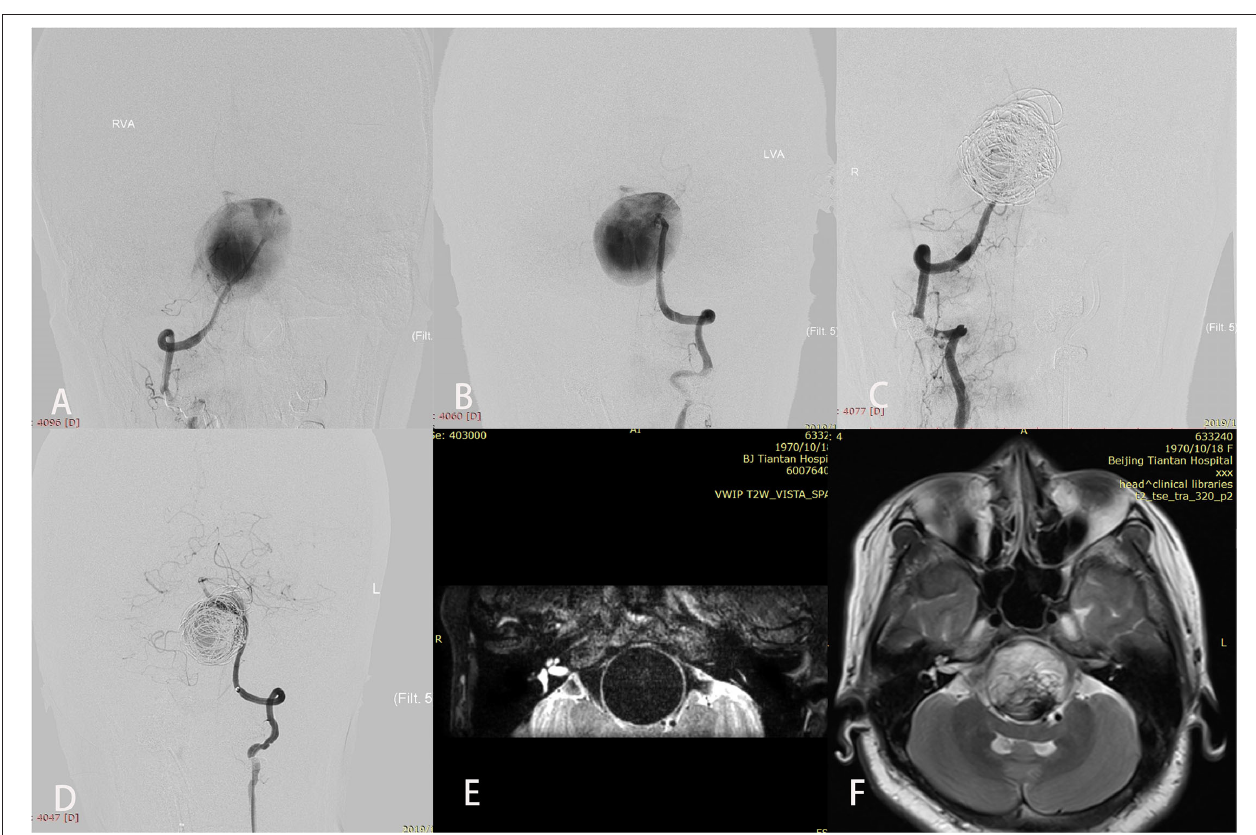
FIGURE 2 | A patient (case 17) with symptoms of mass effect from a giant vertebrobasilar junction aneurysm underwent placement of a single Pipeline embolization device along with coiling and right vertebral artery sacrifice. After treatment, disturbed consciousness and dyspnea developed. Preoperative anteroposterior views of right (A) and left (B) vertebral angiography showed the aneurysm. (C,D) Angiography immediately after the procedure showed successful sacrifice of the right vertebral artery, excellent reconstruction of the basilar artery, and contrast stasis in the lumen of the aneurysm. (E) T2-weighted imaging before the intervention demonstrated a complete flow void within the aneurysm. (F) T2-weighted imaging after treatment showed aneurysmal enlargement and signal inhomogeneity within the aneurysm consistent with